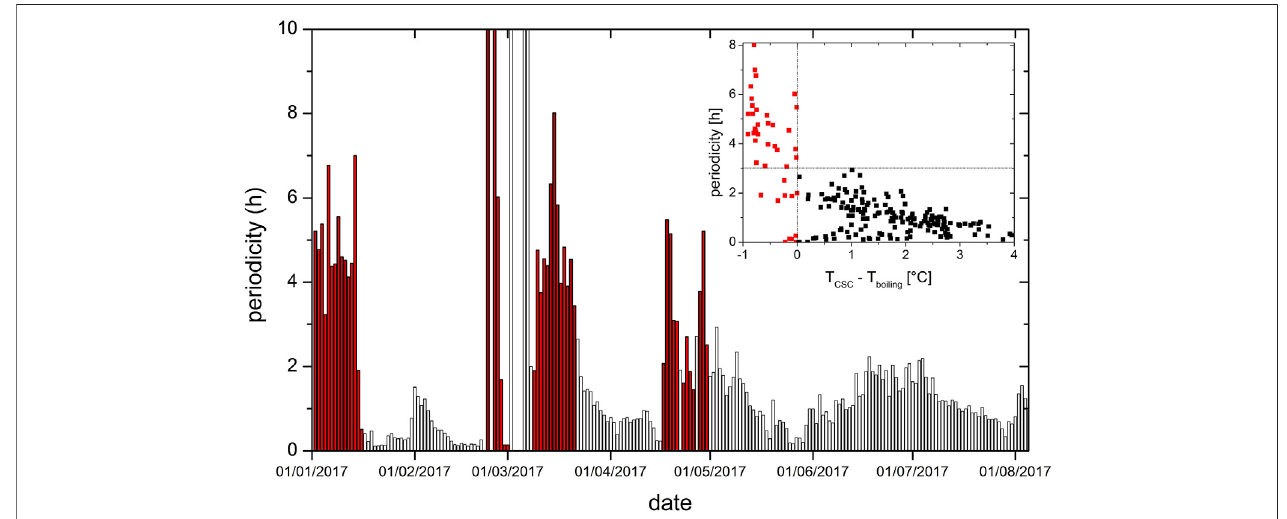
FIGURE 6 | Time periodicity of the Centre fumarole temperature (CSC). Red columns correspond to periods when the centre fumarole temperature (T CSC ) is less than the boiling temperature (T boiling ) ( see Figure 3) . Inset: periodicity vs overheating of the Centre fumarole.